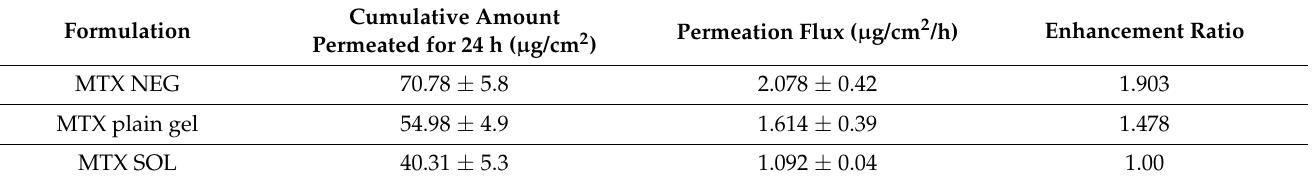
Figure 4. Skin permeation profile of MTX sol, MTX NEG, and MTX plain gel across rabbit skin for 24 h. Data are expressed as mean ± SD ( n = 3). 24 h. Data are expressed as mean ± SD ( n = 3). Table 6. Skin permeation parameters of MTX NEG, MTX plain gel, and MTX sol.